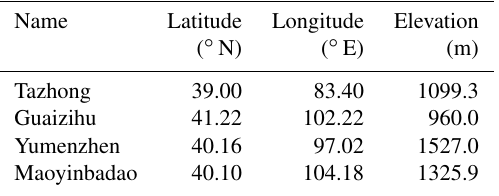
Table 1. Information on the 10m wind stations from the Chinese National Meteorological Center